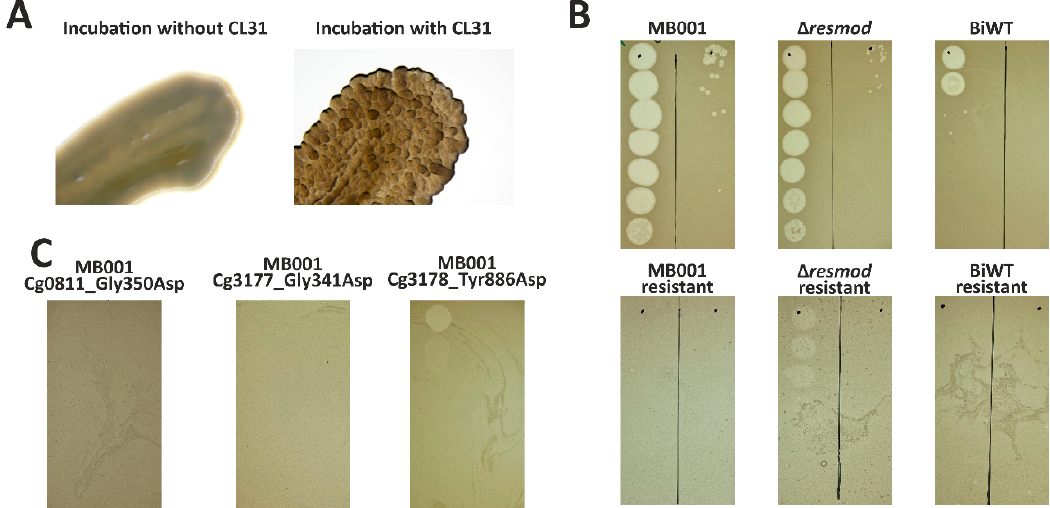
Figure 6. SNPs in genes involved in mycolic acid biosynthesis confer resistance to CL31 infection. ( A ) Colony surface of C. glutamicum WT (left) and a clone isolated after CL31 infection (right). For details on the isolation, see material and methods. ( B ) C. glutamicum clones isolated after CL31 were used to inoculate an overlay agar and perform phage titer determination with a serial dilution of CL31. As controls, the corresponding origin strains were treated similarly (top row). Representative examples out of three replicates are shown. ( C ) A similar titer determination as described in B was conducted with C. glutamicum strains harboring a reintegration of the SNPs (Table 1) found in the resistant C. glutamicum strains.